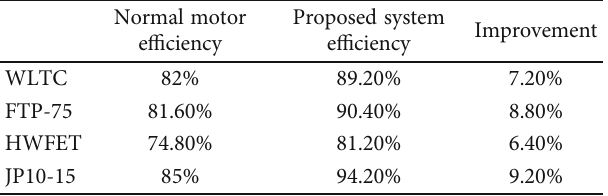
Table 1: E ffi ciency estimation and comparison. Normal